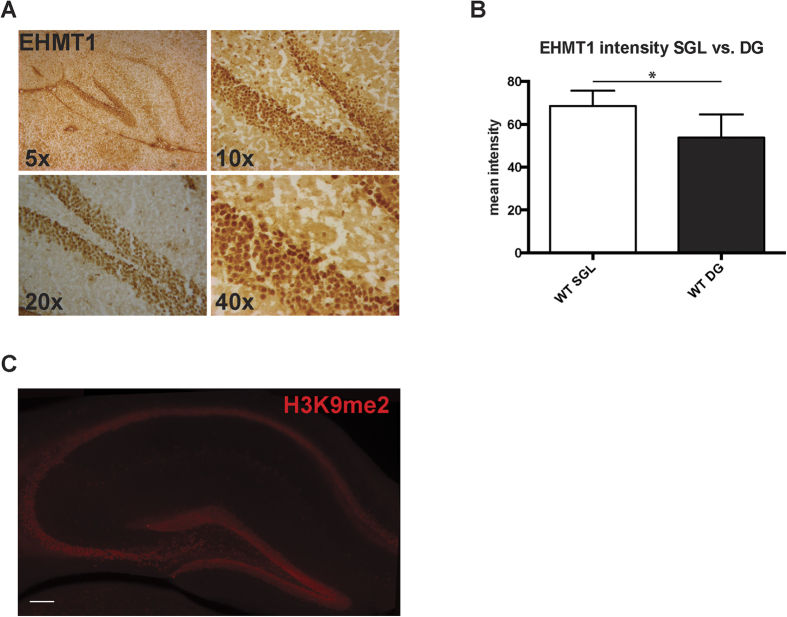
EHMT1 expression pattern in the dentate gyrus.(A) EHMT1 staining intensity in the DG at different levels of magnification (B) Quantification of EHMT1 staining intensity in the SGZ (n = 30 cells) and DG (n = 30 cells). (C) Representative H3K9me2 immunolabeling in a hippocampal section (Scale bar: 100 μm).